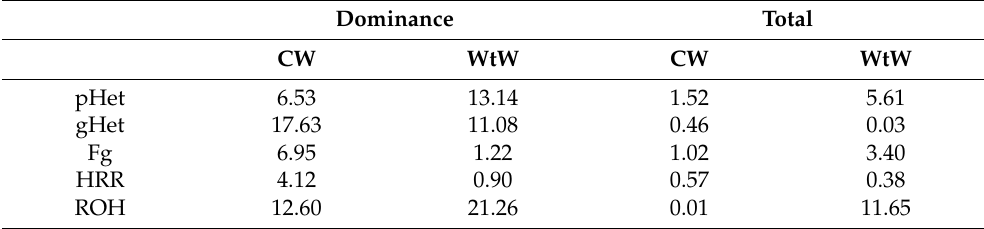
Table 3. Percentage of variation (R 2 × 100) in projected dominance and total (additive + dominance) effects on cow weight (CW) and cumulative weight weaned (WtW) explained by pedigree-based retained heterozygosity (pHet) and genomic indicators of heterosis 1 . Dominance Total CW WtW CW